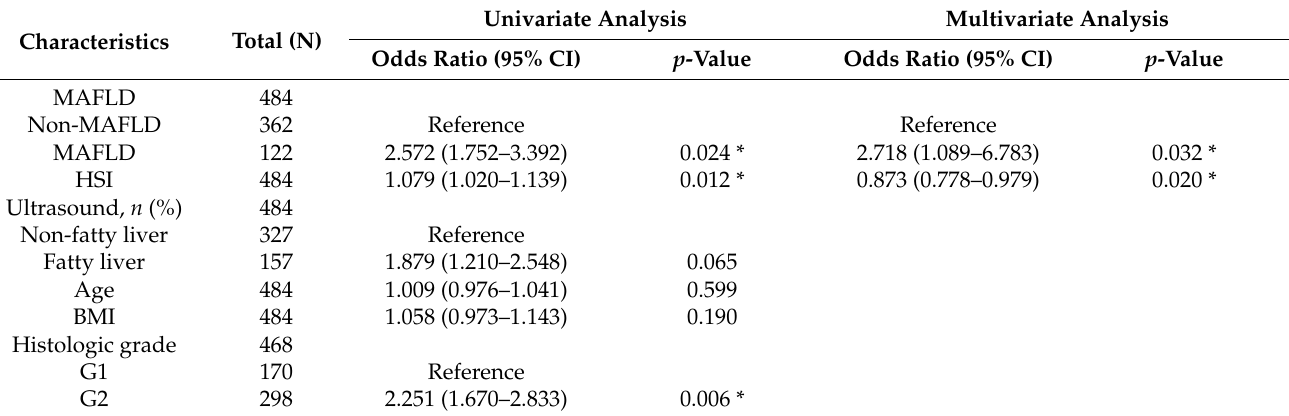
Table 4. Univariate and Multivariate Logistic Regression Analysis of Independent Risk Factors for CSI in Type I EC Patients without T2DM.